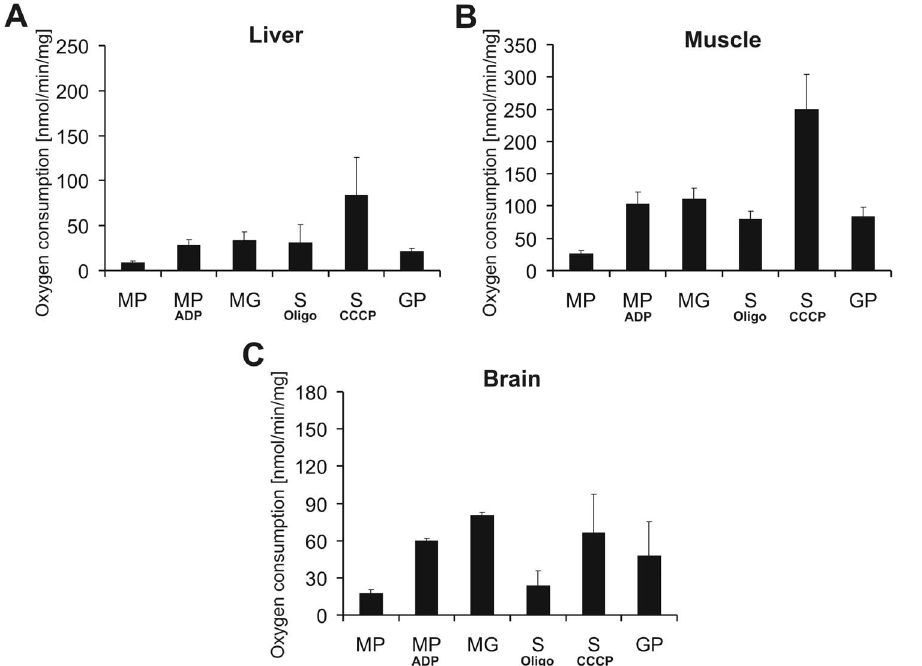
Figure 3. Liver, muscle and brain mitochondria isolated using anti-TOM22 magnetic beads show reliable mitochondrial function. Oxygen consumption of isolated A liver, B muscle and C brain mitochondria were measured by a Clark electrode. Malate + pyruvate (MP) and malate + glutamate (MG) served as specific substrates for complex I, succinate (S, for complex II and glycerol-3-phosphate (GP) for complex III, respectively. ADP was given to malate + pyruvate to determine state III respiration via complex I. Oligomycin and CCCP were used with succinate to assess state IVo and uncoupled respiration, respectively. The given oxygen consumption units are nmol oxygen/min/mg mitochondria. Data are represented as means of three independent experiments 6